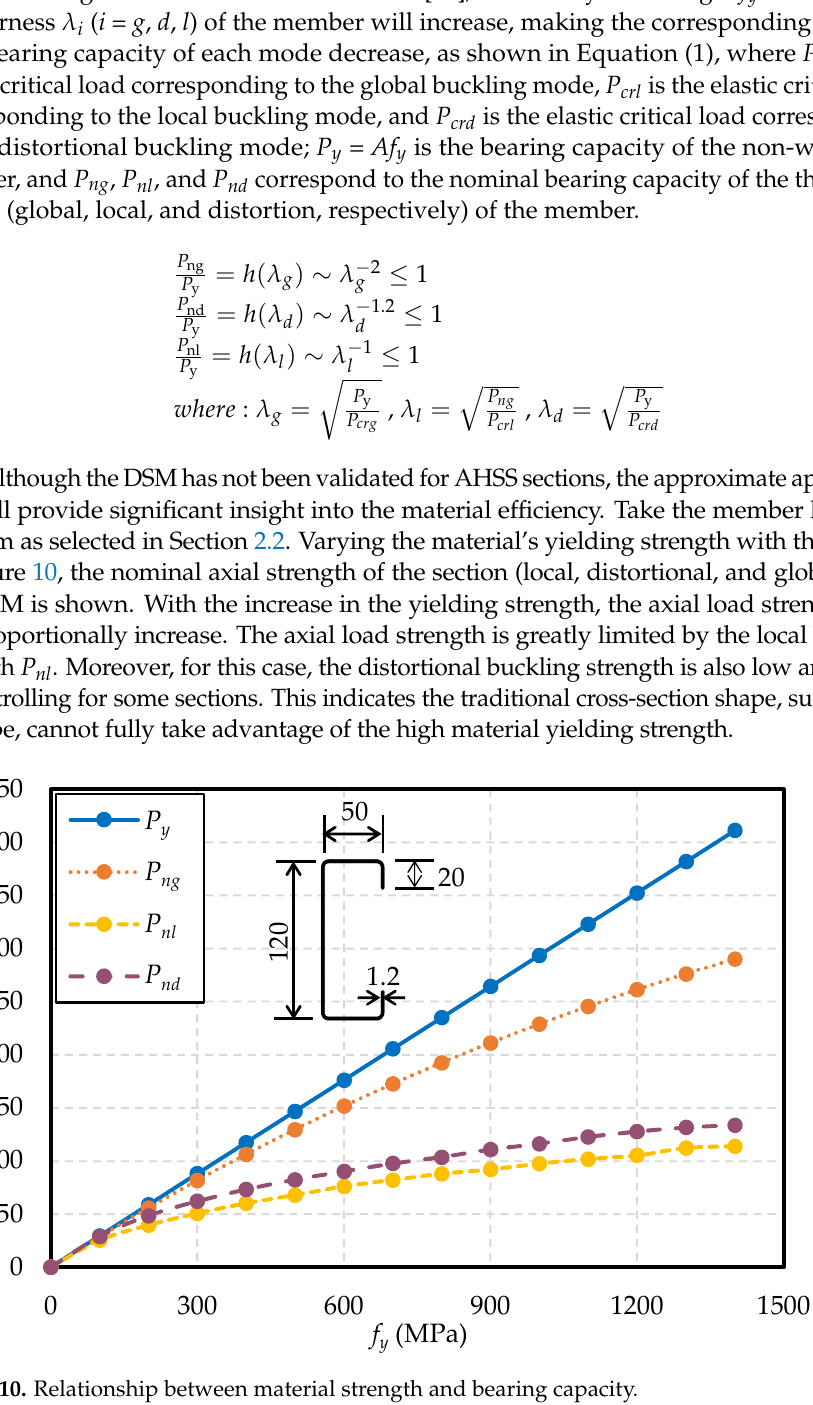
Figure 10. Relationship between material strength and bearing